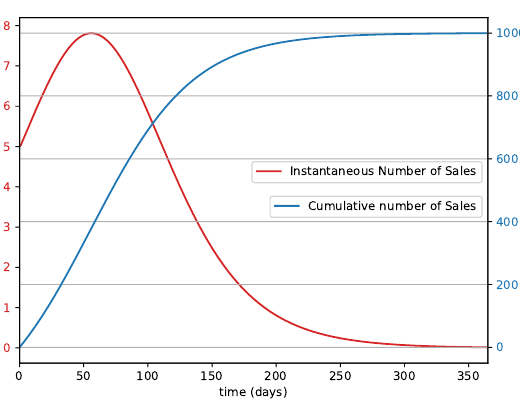
Figure 1. Bass Diffusion Model ( m = 10 4 , p = 5.10 − 3 , q = 2.10 − 2 , T max =